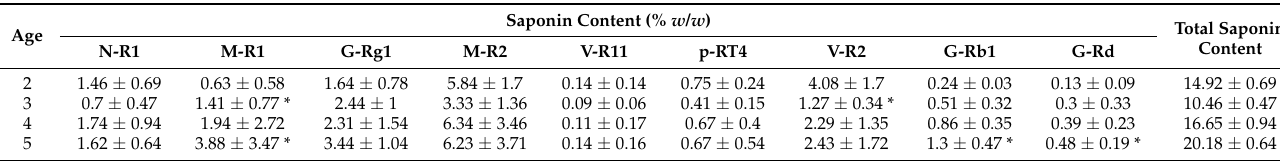
Table 2. The saponin content in main roots of 2- to 5-year-old VGs detected by HPLC–CAD. Results are illustrated as mean ± standard deviation ( n = 5). * p < 0.05 compared with the age of